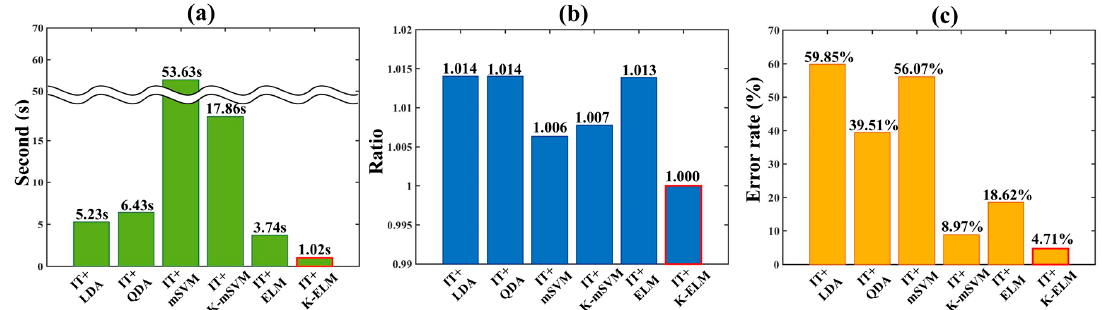
Figure 5. Evaluation of the proposed algorithm in comparison with results of other algorithm such as